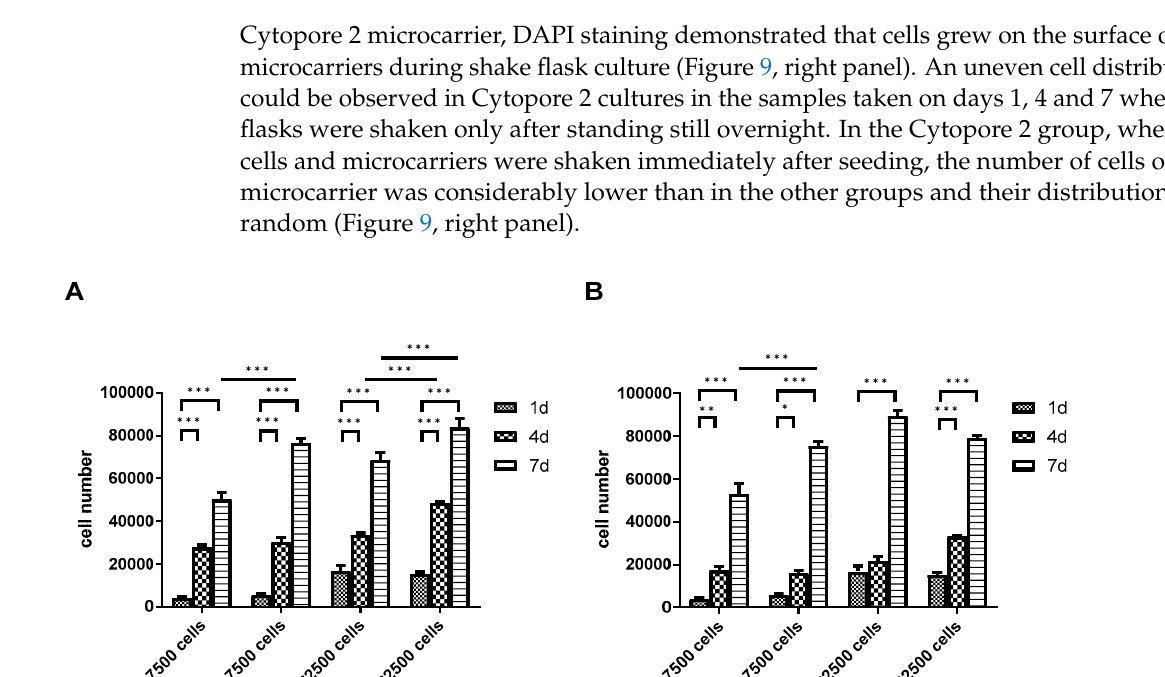
Figure 8. Changes in the number of viable DPSCs cultivated with ( A ) Cytodex 1 (CD1) or ( B ) Cytopore 2 (CP2) in 96-well non-attaching plates under static conditions for 7 days. Initially 7500 and 22,500 cells were seeded into the wells containing 0.2 or 0.4 mg/mL microcarrier. Values are means ± SEM ( n = 5). * p < 0.05, ** p < 0.005, *** p < 0.001 in comparisons as indicated.